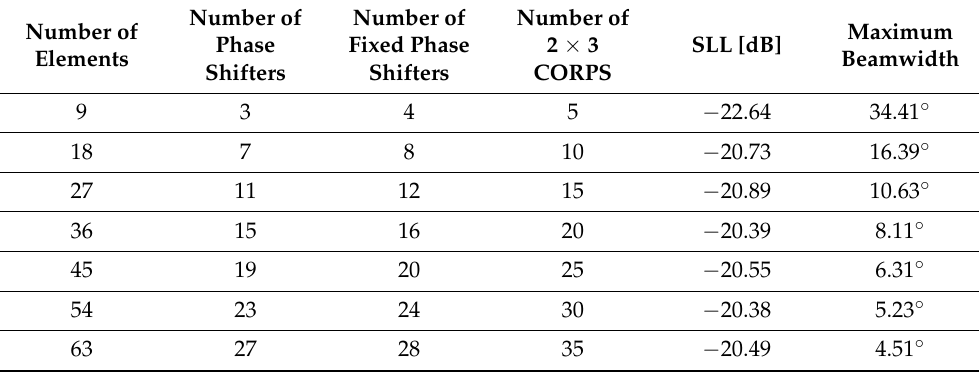
Table 2. Numerical values as the number of antenna elements